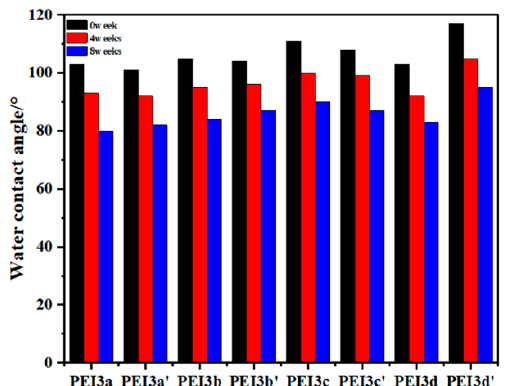
Figure 8. Water contact angles of PEI3a–PEI3d ′ .